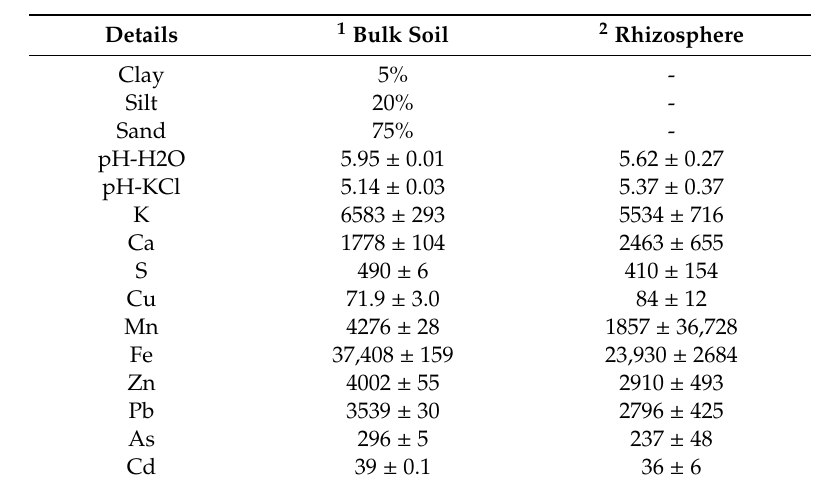
Table 1. Characteristics of the contaminated soil used in the germination experiment. Data are presented as the mean values and standard deviations of the bulk soil and rhizospheric soil of A. capillaris and F. rubra growing in association. Concentrations of elements are all given in mg · kg − 1